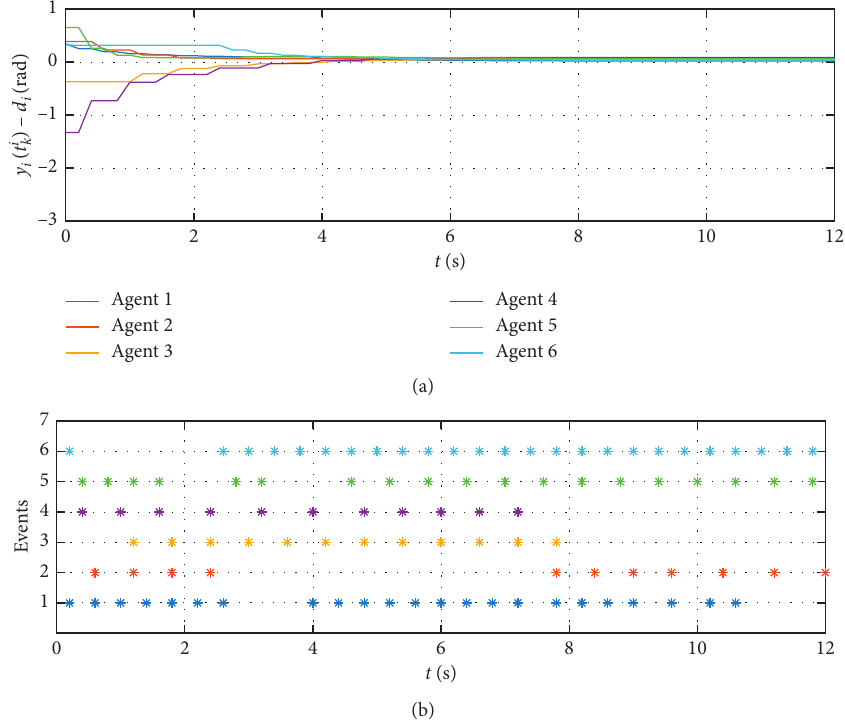
Figure 2: Simulation results of circle formation control for first-order MASs. (a) The evolution of y h � 0 . 2s. (b) The sequence of event-triggered times for i � 1 , 2 , ... , N when h � 0 . 2s.